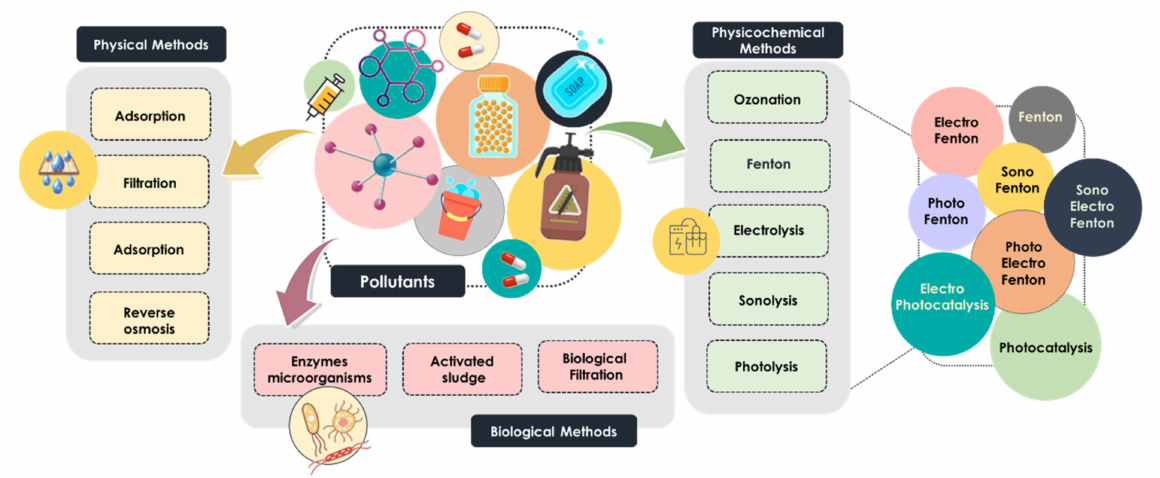
Figure 1. Classification of technologies used in water